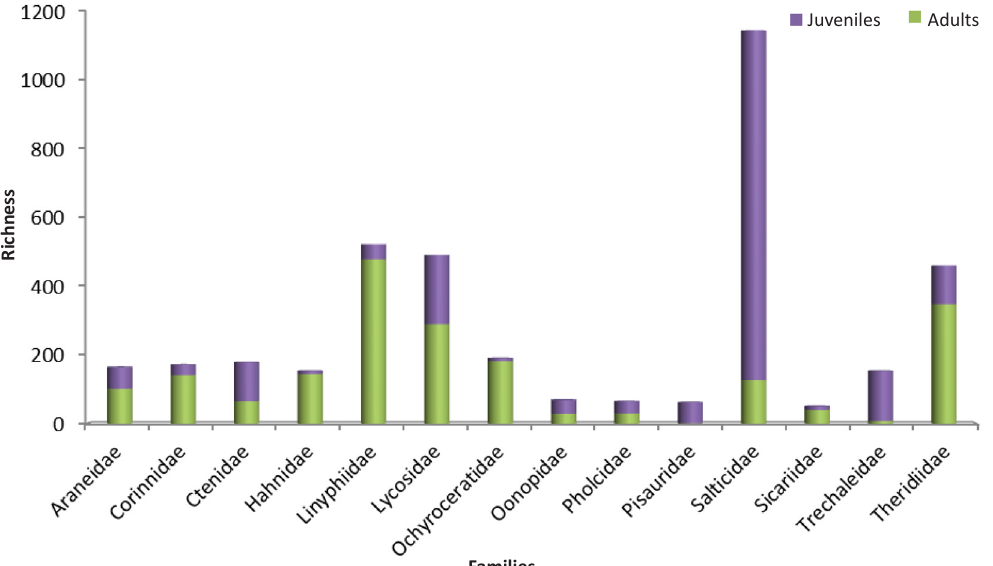
Figure 5. Abundance of adult and juvenile spiders from 14 families sampled that have more than 50 individuals collected on soil of Ecological Park Centennial Jatoba between November 2006 and August